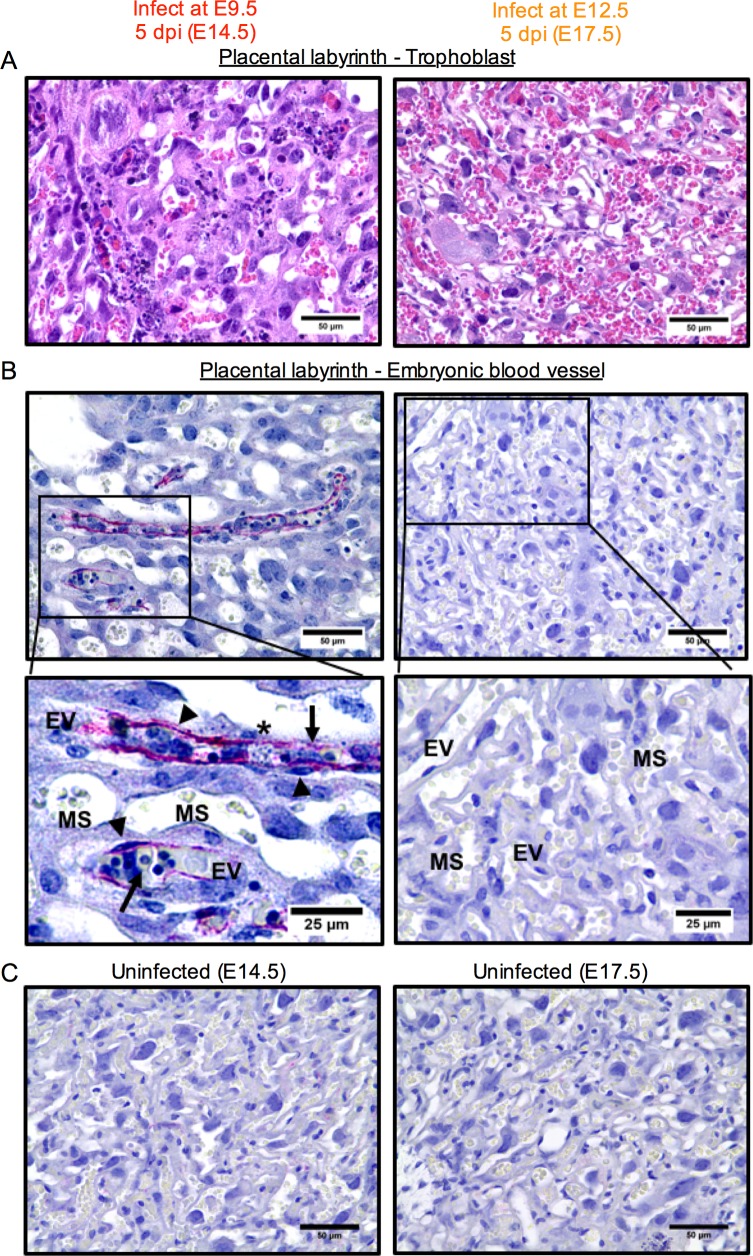
Pathology of the placentas of ZIKV-infected dams depends on the time of exposure during gestation.Pregnant dams were infected with 3.4 × 105 PFU of ZIKV at E9.5 or E12.5, and sacrificed 5 dpi at E14.5 (left panels) or E17.5 (right panels), respectively, as illustrated in Fig 2D. Representative images of placental labyrinth stained with H&E (A) or ZIKV E protein (red) with hematoxylin counterstain (blue) (B and C) are shown. Necrosis and viral antigen were observed in the labyrinth of dams infected at E9.5, but not in dams infected at E12.5. Arrows indicate nucleated embryonic red blood cells. Arrowheads indicate the ZIKV antigen stain and highlight morphology of infected cells and antigen staining pattern. Asterisks indicate areas of necrotic cell debris. (C) Tissues from uninfected dams at the same gestational age were used as negative controls for viral staining. MS, maternal sinus; EV, embryonic blood vessel. Scale bar, 50 μm or 25 μm.